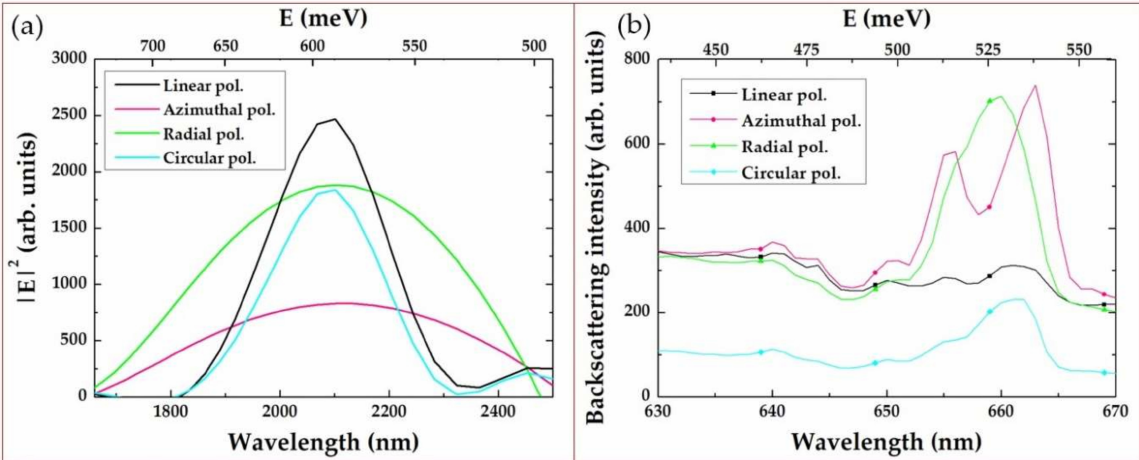
Figure 7. ( a ) Maximal values | E | 2 calculated inside the nanorod trimer for various polarizations depending on the wavelength (bottom x -axis) and photon energy (top x -axis). ( b ) Experimental backscattering spectra of the Stokes-component intensity. Top x -axis shows difference in photon energy with laser pump (515